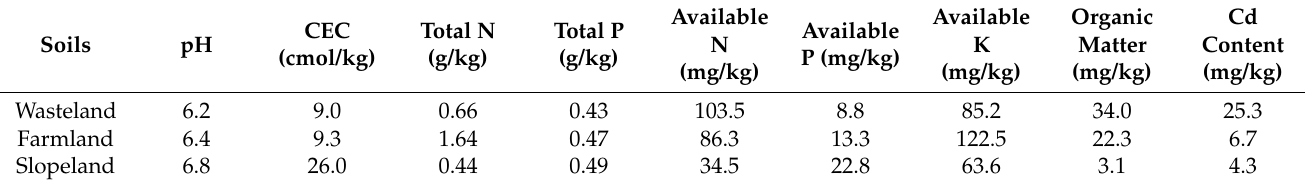
Table 1. Soil physicochemical